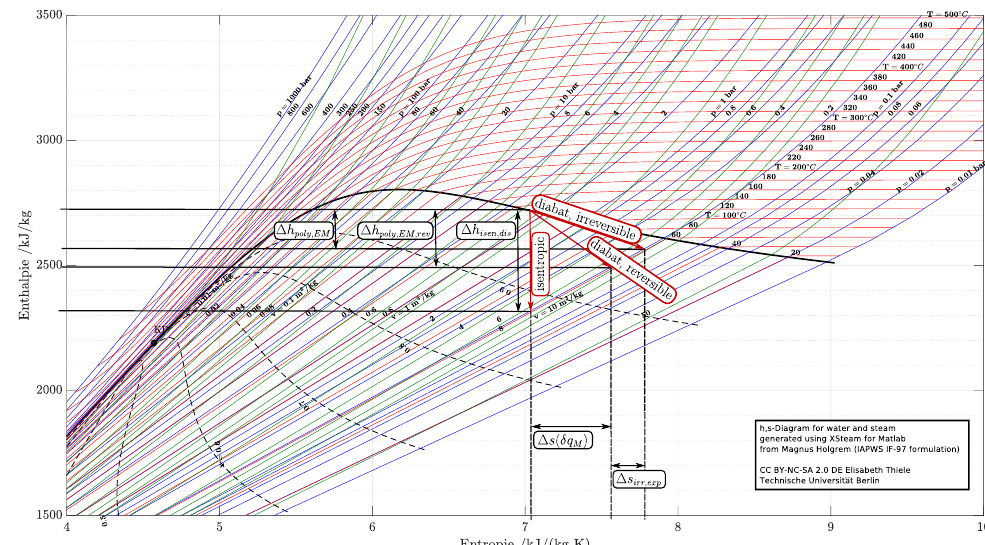
Figure A5. Illustration of enthalpy differences in the equations of expansion and compression device efficiencies, examplified for the polytropic